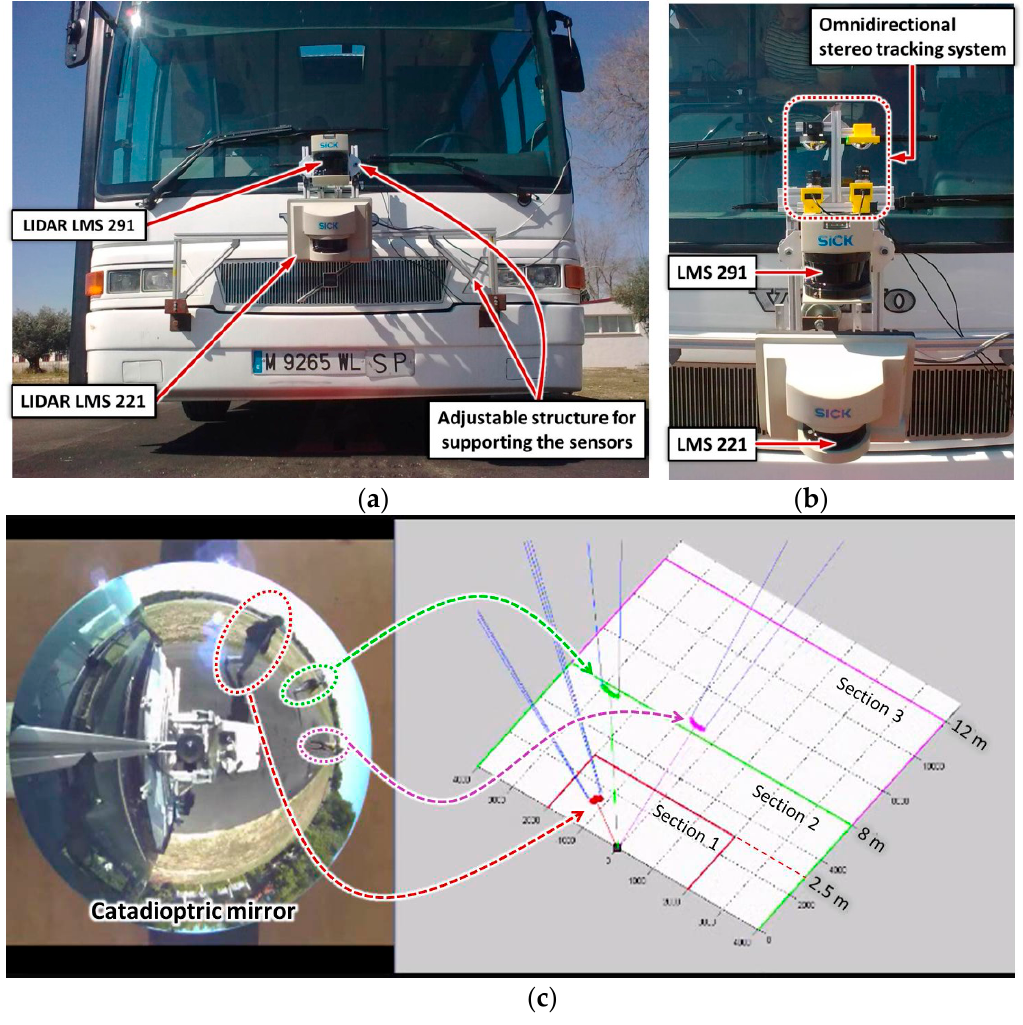
Figure 7. ( a ) LIDAR sensors placed at the bus front; ( b ) omnidirectional stereo tracking system; ( c ) dynamic obstacle detection (more critical close up (Section 1), intermediate (Section 2) and less critical (Section 3)).